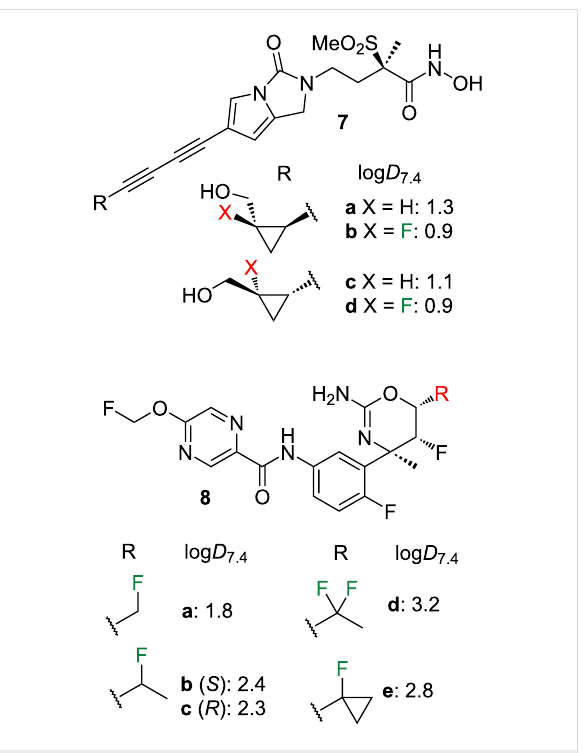
Figure 2: Lipophilicity modulation examples involving fluorinated cyclo- propane derivatives (measured experimentally via shake-flask